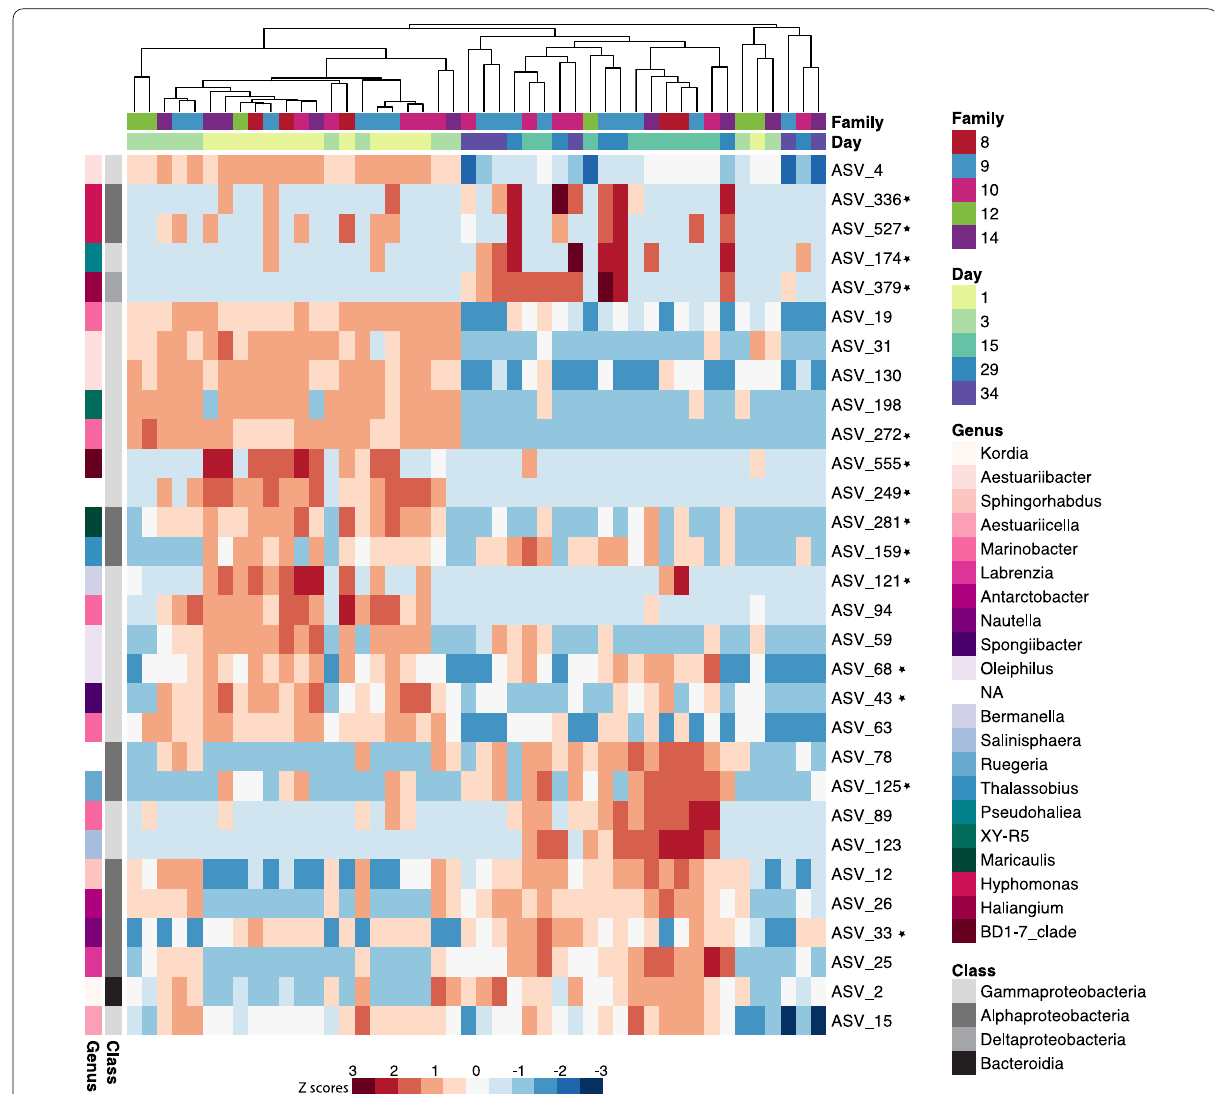
Fig. 4 Heat map of the 30 ASVs that are the most important contributors to a Random Forest classification model that was trained to predict larval stage from microbial community composition. The heat map shows the relative abundance of the ASVs in samples of the different larval stages (Day), samples are clustered using Sorensen‑Dice dissimilarity distances. More detailed taxonomic information can be found in Additional file 1: Table S4. Stars denote ASVs that were not detected in tank water and algae samples with a relative abundance greater than